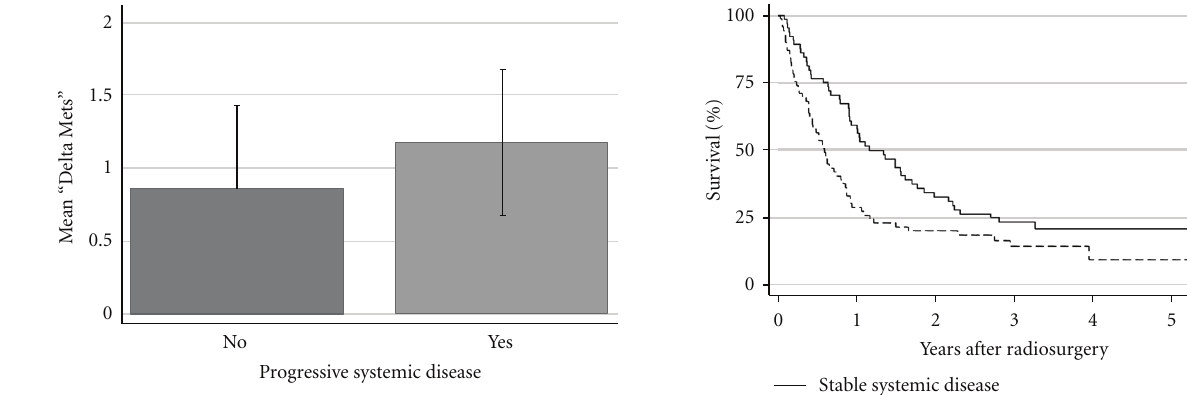
Figure 2: Bar graph demonstrating the relationship between pro- gressive systemic disease and the number of additional metastases (“Delta Mets”) identified at the time of GK-SRS. Error bars are shown.